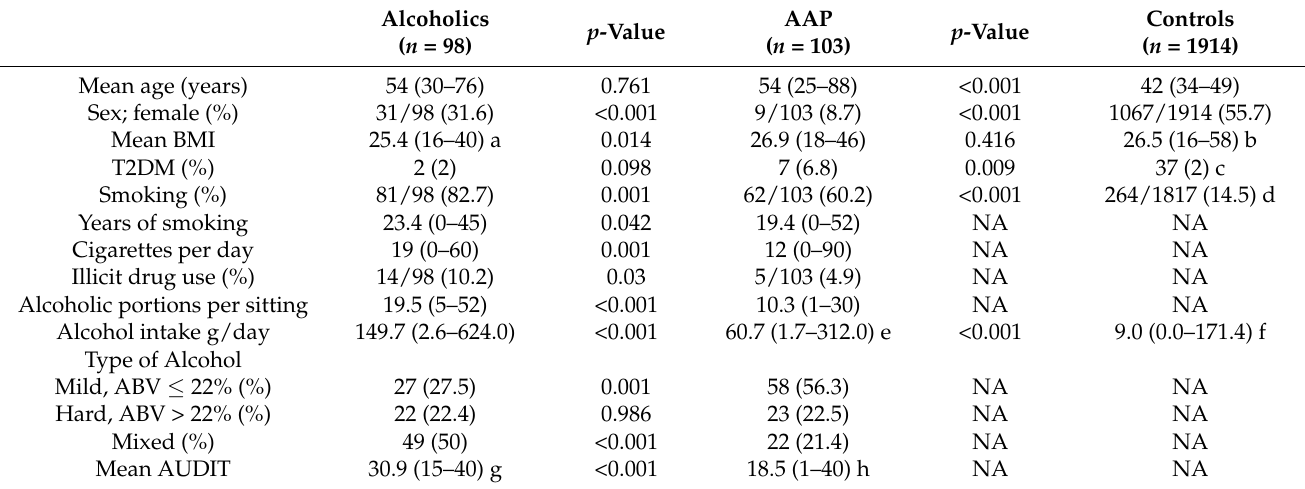
Table 1. Demographic and clinical characteristics of alcoholics without pancreatitis, AAP patients and control population.